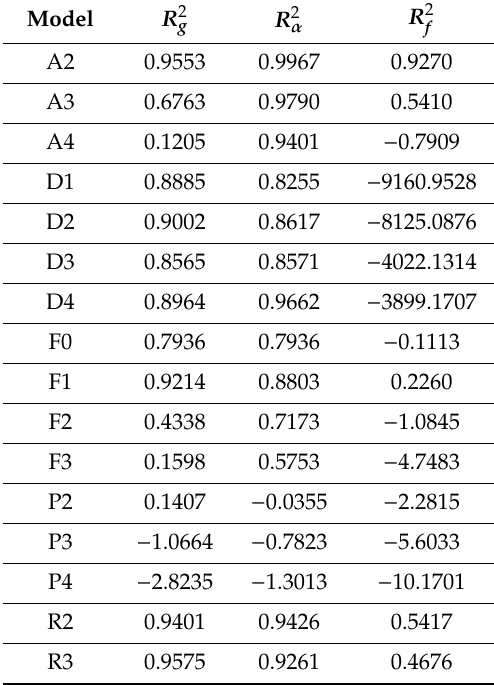
Table 2. The determination coe ffi cients calculated at every step of the COMF method in the case of the desolvation of sulfameter solvates at 47.19 ◦